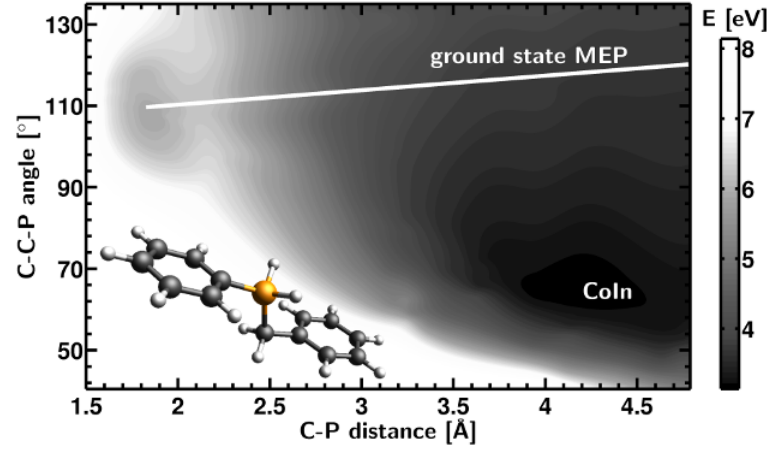
Fig. 1. Two dimensional potential energy surface of the first excited state of the phenylmethylphenylphosphonium ion (inlay). In addition to the primary dissociation coordinate, the C-P distance, the C-C-P angle is needed to reach the conical intersection (CoIn) which couples the homolytic and the heterolytic product channel. The black line indicates the direction of the minimum energy path (MEP) in the ground